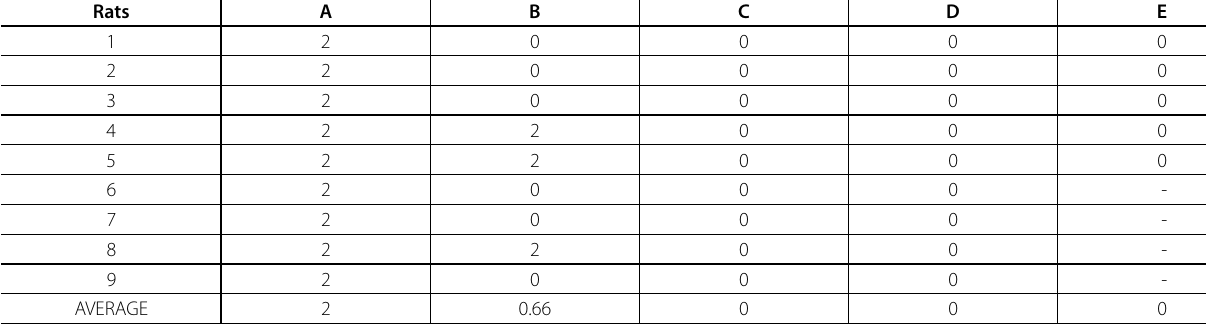
P <0.0001 (Kruskal-Wallis) Histopathological classification of intestinal parenchyma injury in